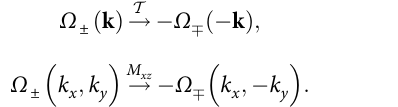
Fig. 2b – e. The BCs are presented along the k y -direction across the X valley (the blue dashed line in Fig. 2a). As P increases, two neighboring BC peaks with opposite signs develop and they gradually move away from each other (Fig. 2b). Once the ferroelectricity fl ips, the sign of the BC distribution also changes (Fig. 2b, c). In contrast, the SOC alters the BC insigni fi cantly (Fig. 2d, e). The BC pro fi le is well maintained regardless of the value of λ . The dependence on P and λ demonstrates that the BC is governed by the ferroelectricity rather than the SOC.